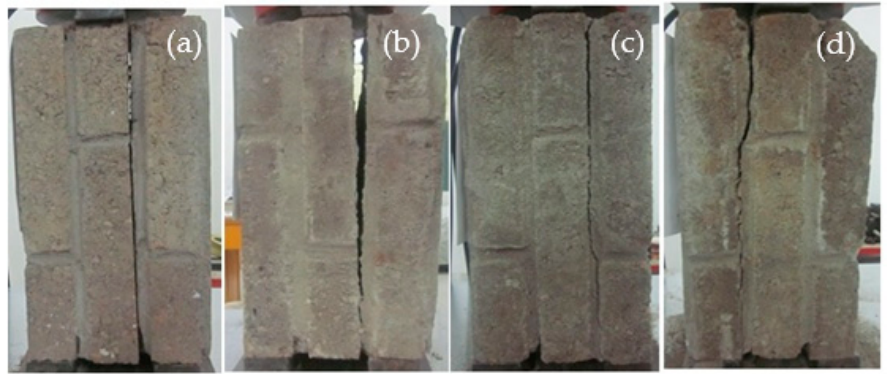
Figure 10. Failure pattern of shear specimen under different corrosion cycles. ( a ) KJMA. ( b ) KJMB. ( c ) KJMC. ( d ) KJMD.